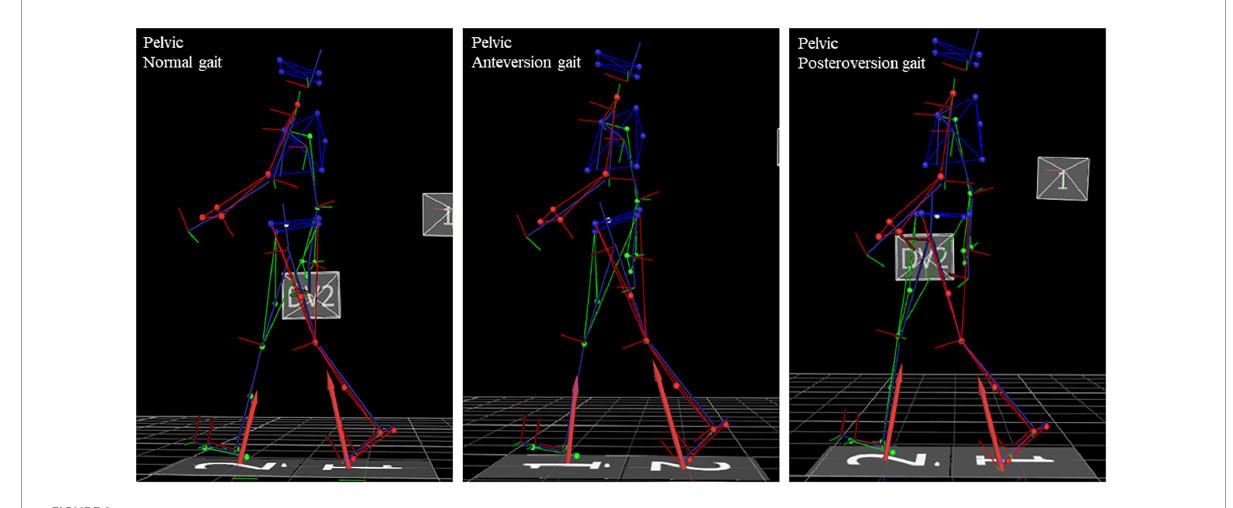
FIGURE1 Full body reconstruction 3D gait analysis of the three conditions of